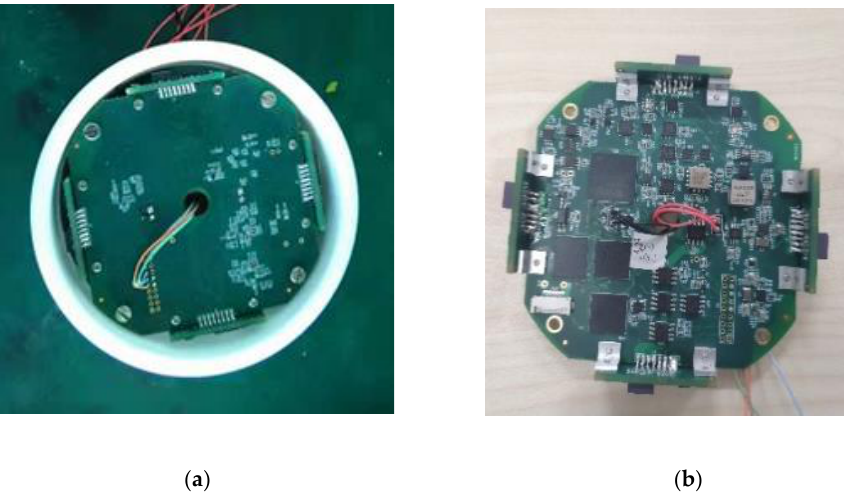
Figure 12. The parachute scanning platform attitude measurement device. ( a ) The bottom of the circuit; ( b ) The top of the circuit.